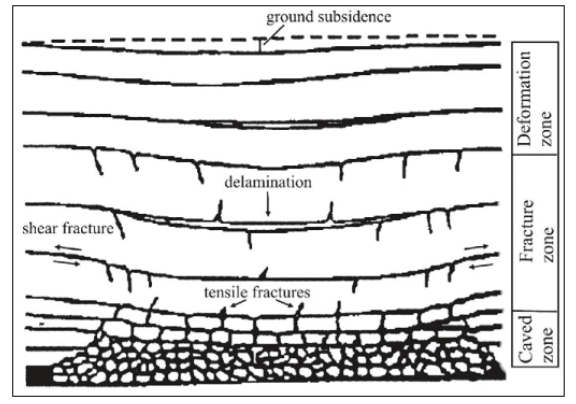
Fig. 1. Caved zone, fractured zone and sagging zone formed after exploitation of a longwall coal-mining panel (after Peng and Chiang [19])